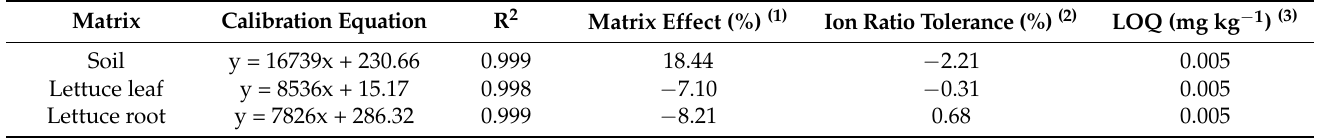
Table 1. Calibration equations, coefficient values of determinations, matrix effects, ion ratios and LOQ values of diazinon.